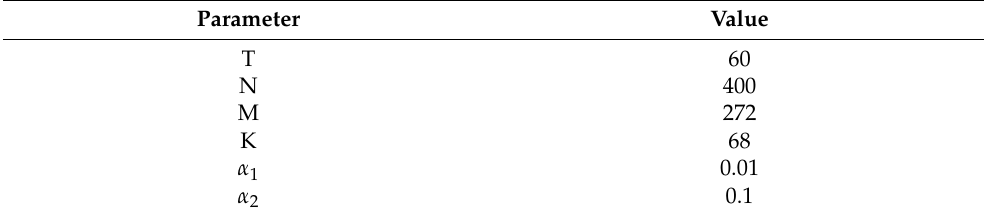
Table 1. Reconstruction parameters used in simulation.